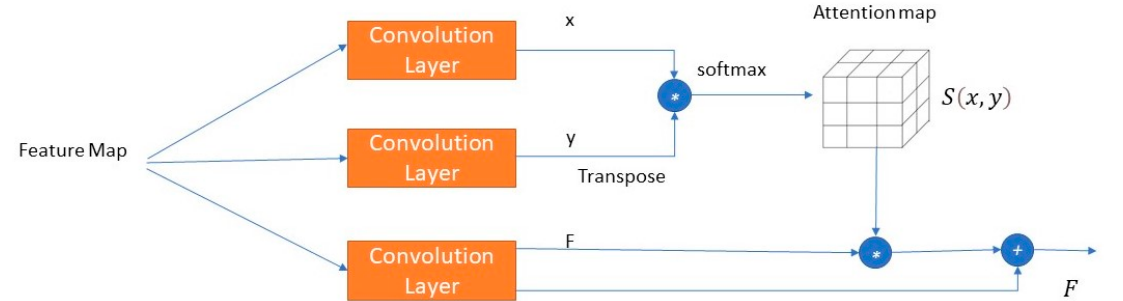
Figure 2. Overall Architecture of the